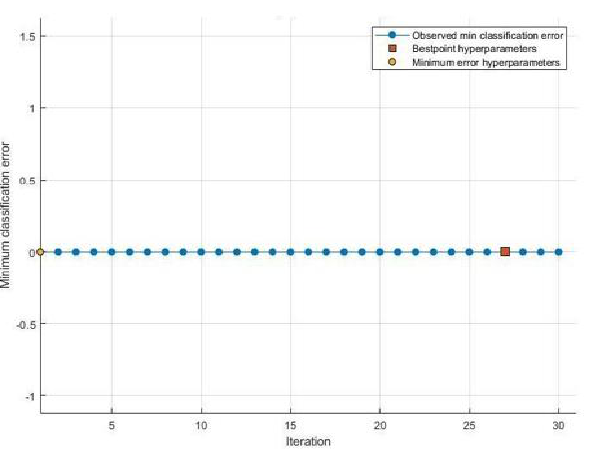
Fig. 22. SSL renegotiation minimum classification error of grid search based optimized tree